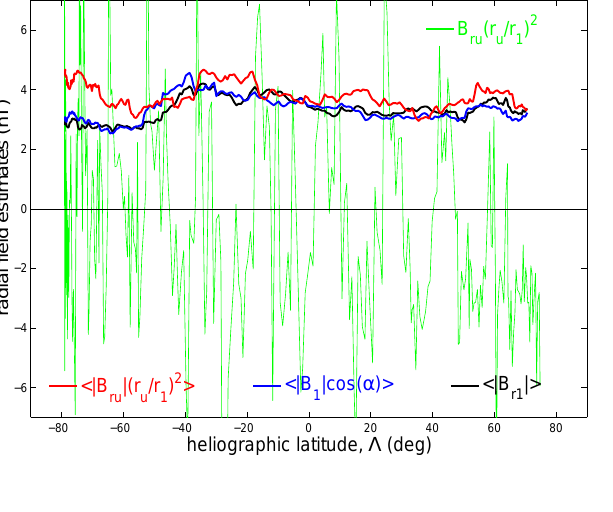
Fig. 11. Same as Fig. 7 for the second perihelion pass. Fig. 12. Same as Fig. 8 for the second perihelion